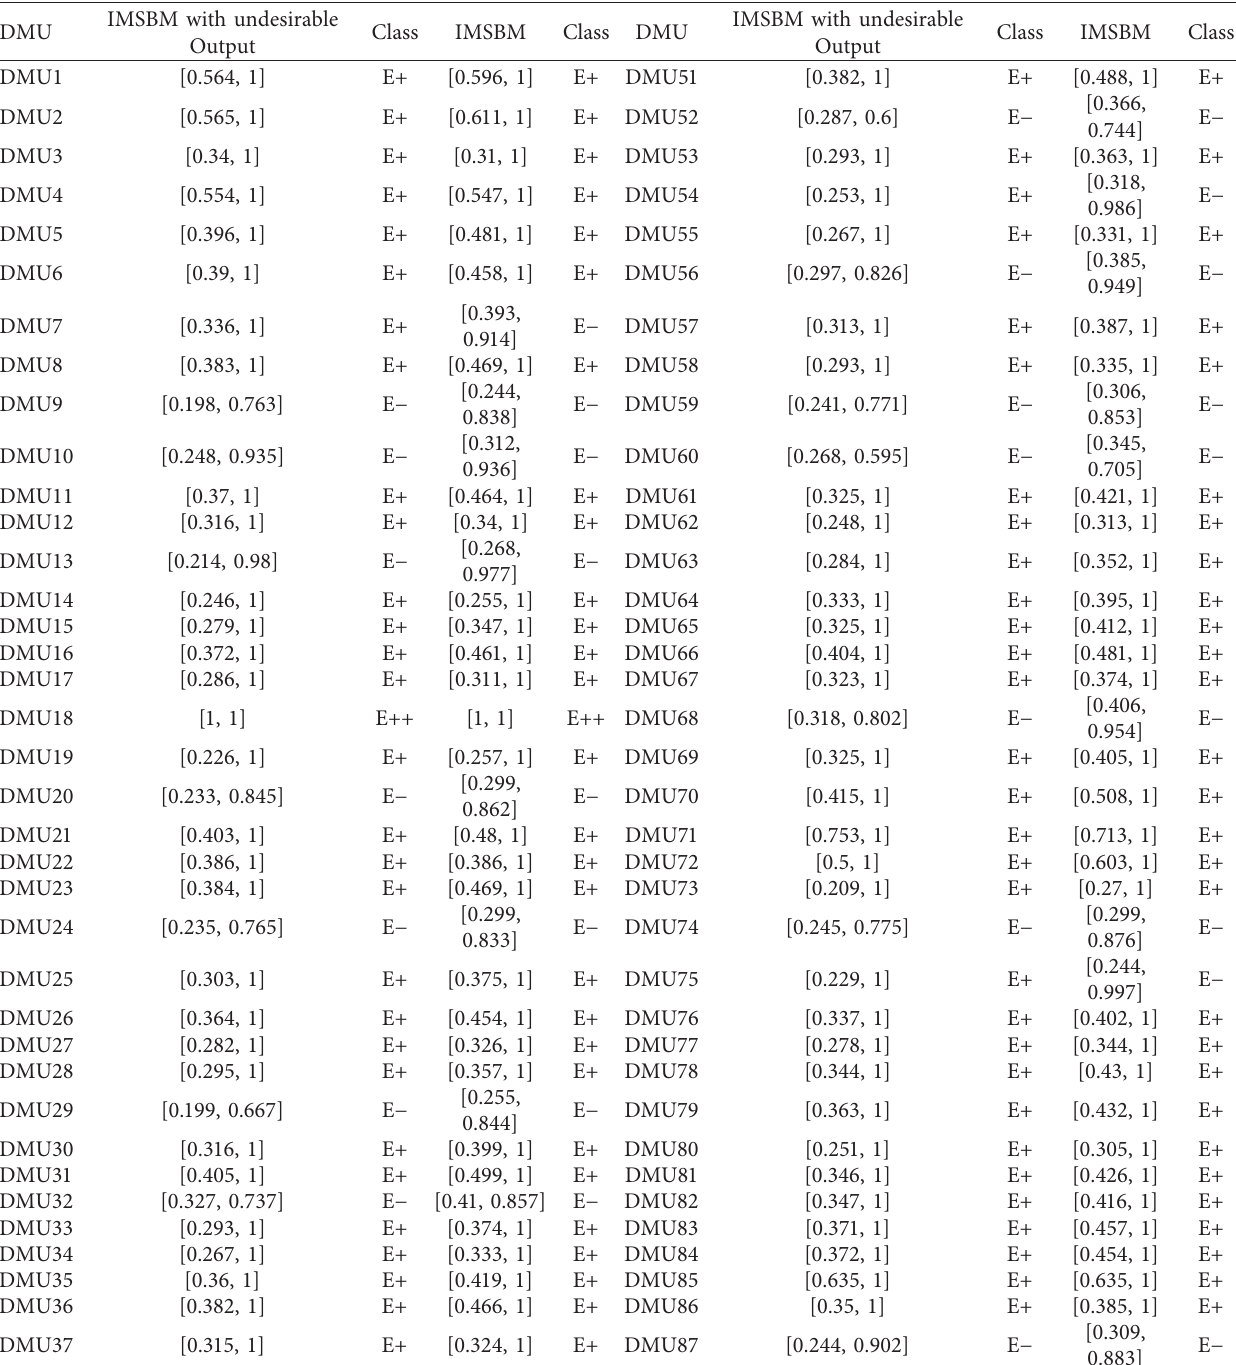
Table 3: Results of the interval efficiency and